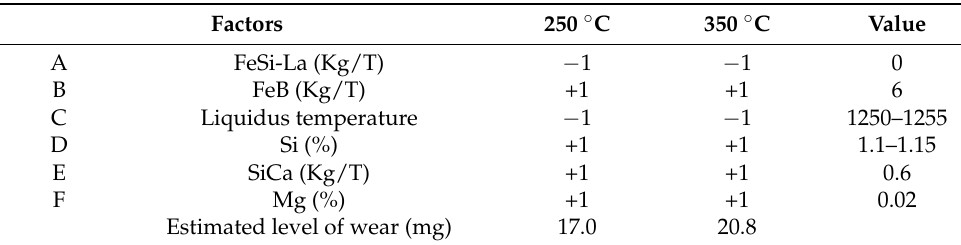
Table 16. Optimal combination of levels for minimising wear in zone III.